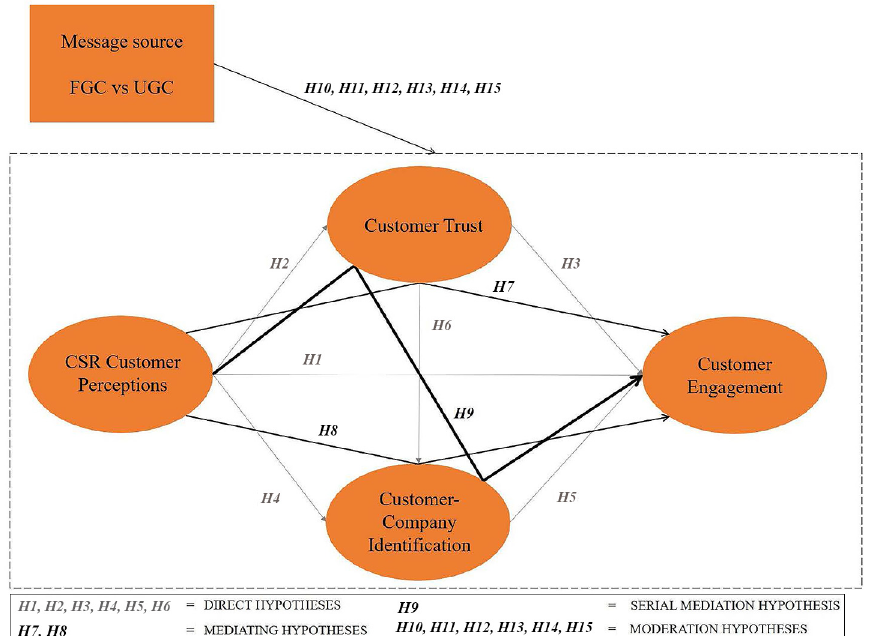
Figure 1. Conceptual